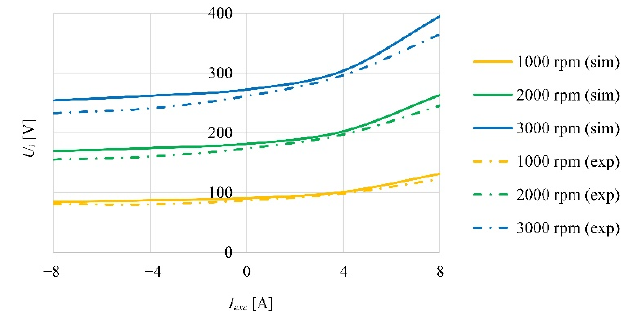
Figure 12. Back-EMF RMS value vs. DC control coil current.